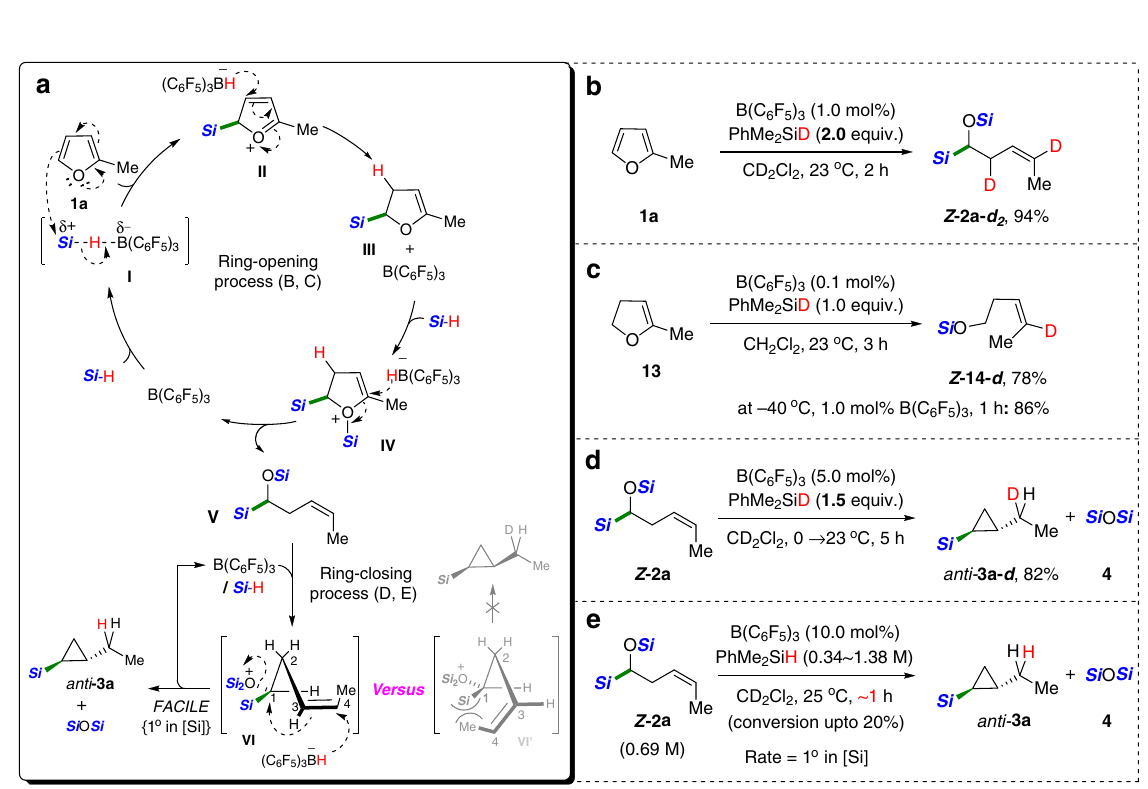
Figure 3 | Mechanistic experiments and proposed catalytic pathway. ( a ) Proposed pathway of the B(C 6 F 5 ) 3 -catalysed silylative ring-opening of furans and subsequent cyclopropanation. For simplicity, hydrosilane is shown as Si -H/D ( Si ¼ SiMe 2 Ph). ( b ) Deuterium labelling experiment. ( c ) A model reaction with 2,3-dihydro-5-methylfuran. ( d ) A test ring-closing reaction of Z -2a with 1.5equiv. of deuterated hydrosilane. ( e ) Rate-order assessment of silane based on initial rates in a range of initial silane